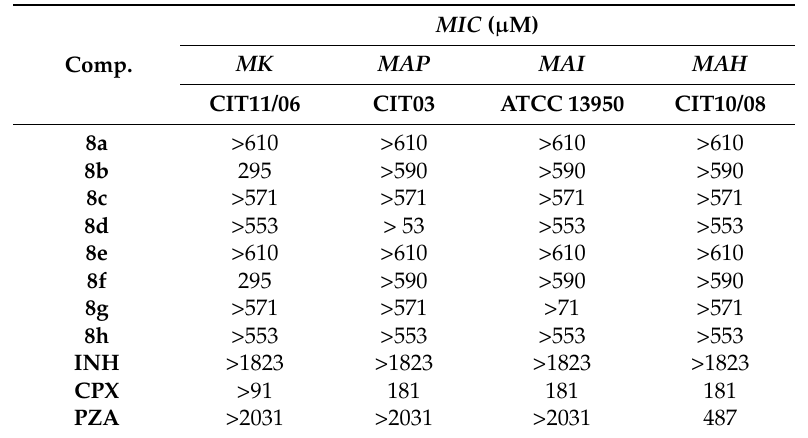
Table 5. The in vitro activity (the MIC values were expressed in the µ M units) of the inspected compounds 8a – h and reference drugs isoniazid (INH), ciprofloxacin (CPX) and pyrazinamide (PZA) against M. kansasii CIT11/06 ( MK CIT11/06), M. avium subsp. paratuberculosis CIT03 ( MAP CIT03), M. avium intracellulare ATCC 13950 ( MAI ATCC 13950) and M. avium hominissuis CIT10/08 ( MAH CIT10/08),